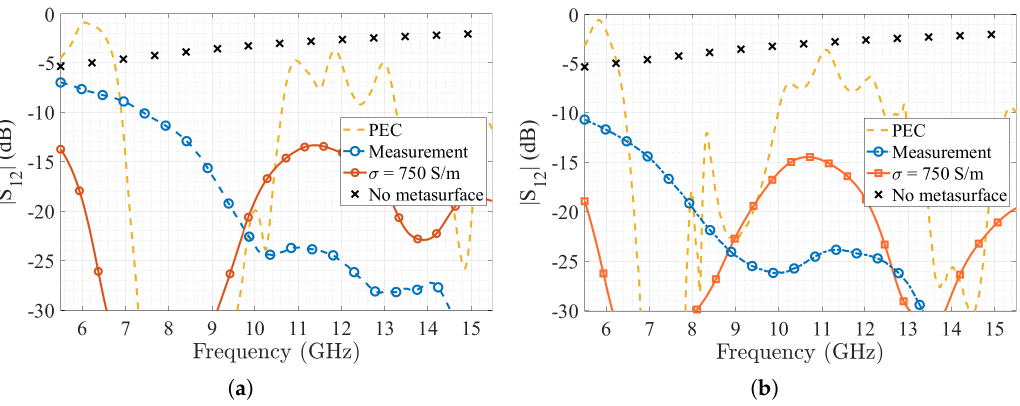
Figure 16. Measurement results of the transmission coefficient as function of the frequency and compared with simulated results for the two constructed metasurfaces with a suspended microstrip line; ( a ) 1 × 4 mushroom metasurface; ( b ) 3 × 4 mushroom